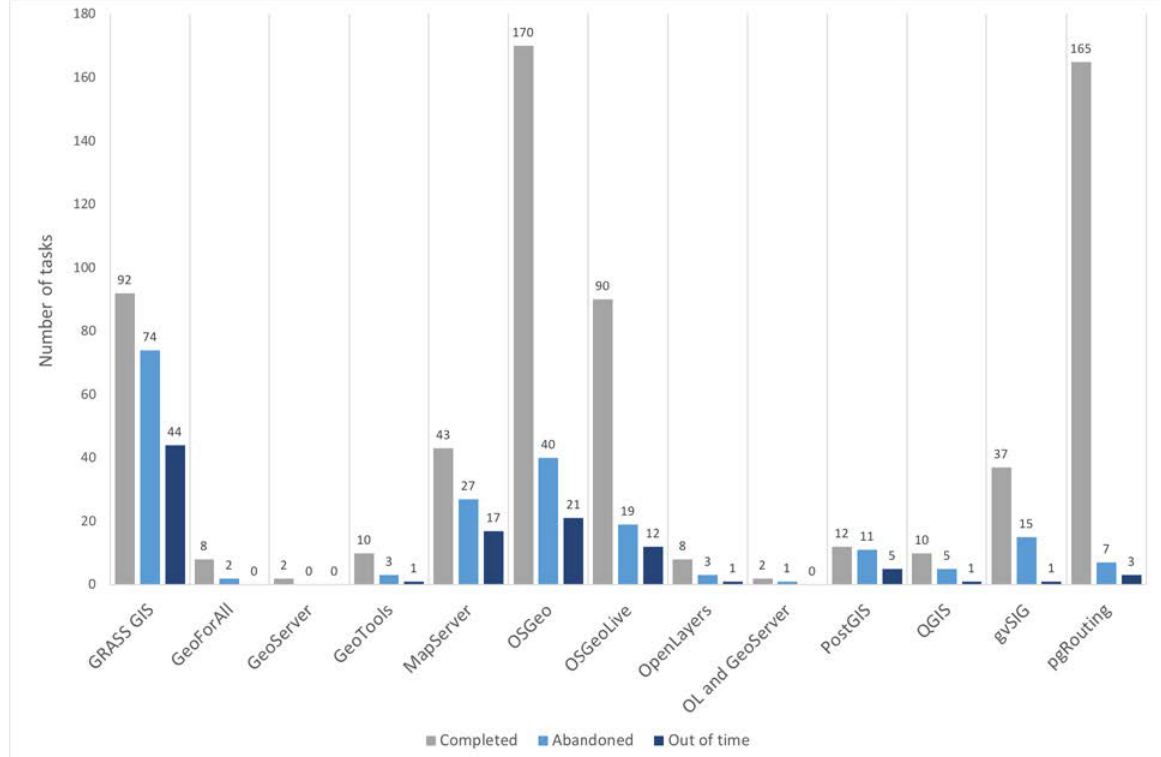
Figure 5. Number of tasks per OSGeo